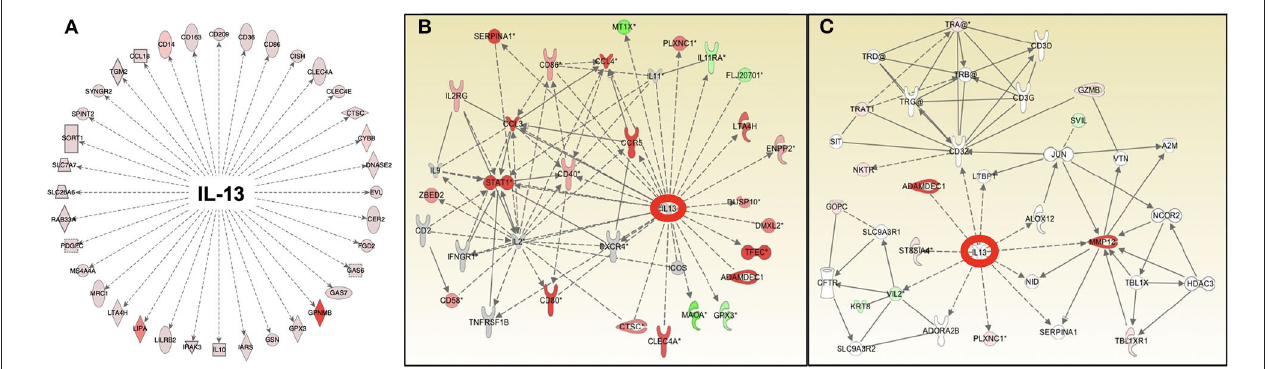
Frontiers in Immunology |